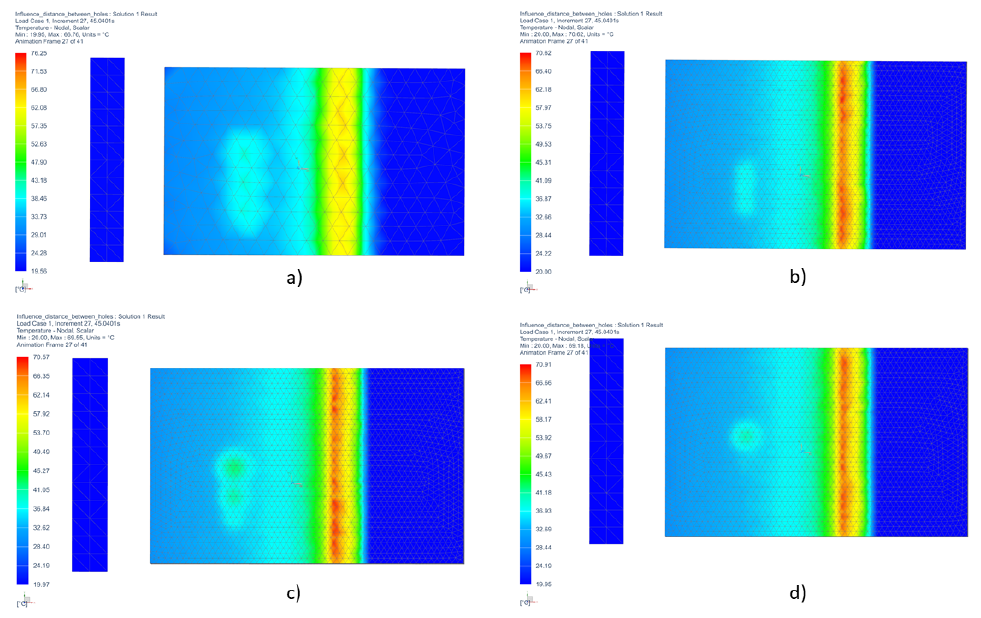
Figure 12. The influence of the intermediate distance between samples on the contrast is visualised in four situations. Image ( a ) represents a simulation of three defects with a diameter of 25 mm, a depth of 5 mm under the surface and an intermediate distance of 27 mm between the centres of the defects. The heat reflected by the defects influences each other resulting in a reduction of the contrast between the separate defects. The resulting hotspot is bigger than the area of the defects. Visualisation ( b ) represents a similar simulation performed on defects of 12 mm diameter, starting 5 mm underneath the top surface and at an intermediate distance of 15 mm of each other. The heat reflected by the separate defects influences the contrast making it impossible to distinguish the defects. Smaller defects, however, reflect less energy in comparison to bigger defects making it harder to detect them. Multiple small defects close to each other will show as a bigger defect, but with more contrast than the individual defects. Defects of different diameters are simulated in subfigure ( c ) where the intermediate distance is 25 mm between the defects. The defects have diameters of 25 mm, 20 mm and 12 mm. The two bigger defects can still be distinguished from each other. The smallest defect however shows as a part of the other defect. Subfigure ( d ) shows the influence of defects placed at different starting depths from the top surface. The defects all have a diameter of 25 mm and are placed at a depth of 5 mm, 10 mm and 15 mm underneath the surface. As the heat wave requires a specified amount to reach the top of the defect and reflect to the top surface, the different defects will not result in hotspots at the same moment in the inspection. Therefore, the influence of deeper defects will effect the top defect minimally. Deeper defects, however, will be less visible to detect because of the hotter regions caused by defects above. The defects closest to the surface will not have the biggest contrast since the parameters are not optimal, but they will still remain hot, disturbing the detection of defects at a greater distance from the top surface. This occurrence makes a flat bottom hole plate with defects at different depths not the most suitable test